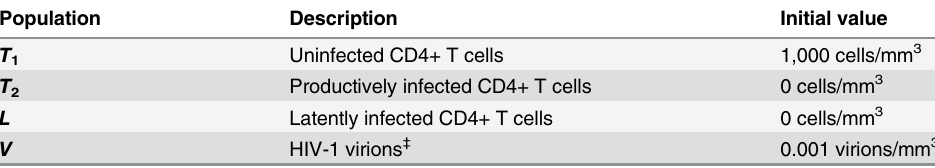
Table 1. Basic HIV-D model populations and initial values [35].